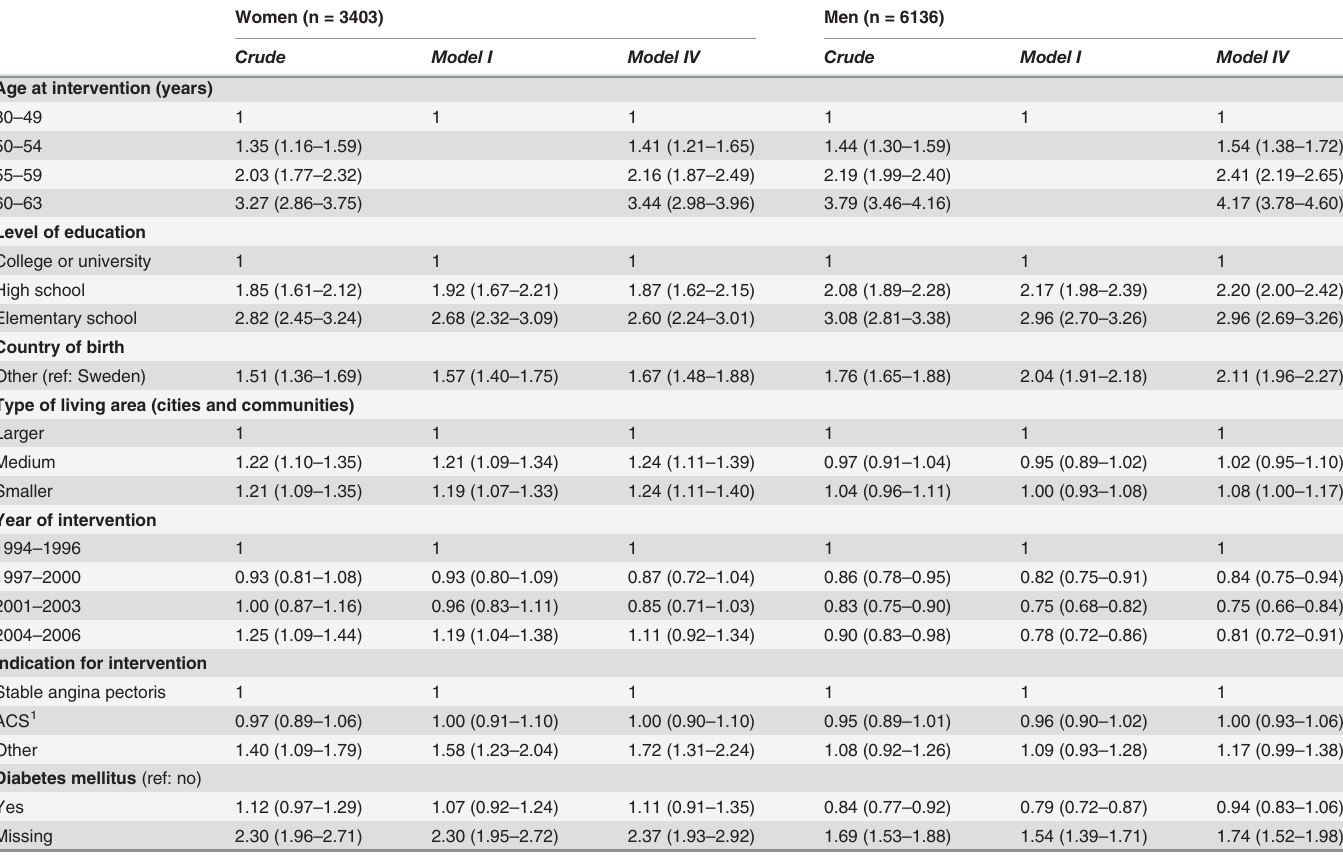
Table 5. Crude and adjusted odds ratio (OR) with 95% con fi dence intervals (CI) for disability pension (DP) at time of a fi rst percutaneous coronary intervention (PCI), among women and men, with regard to socio-demographic and medical